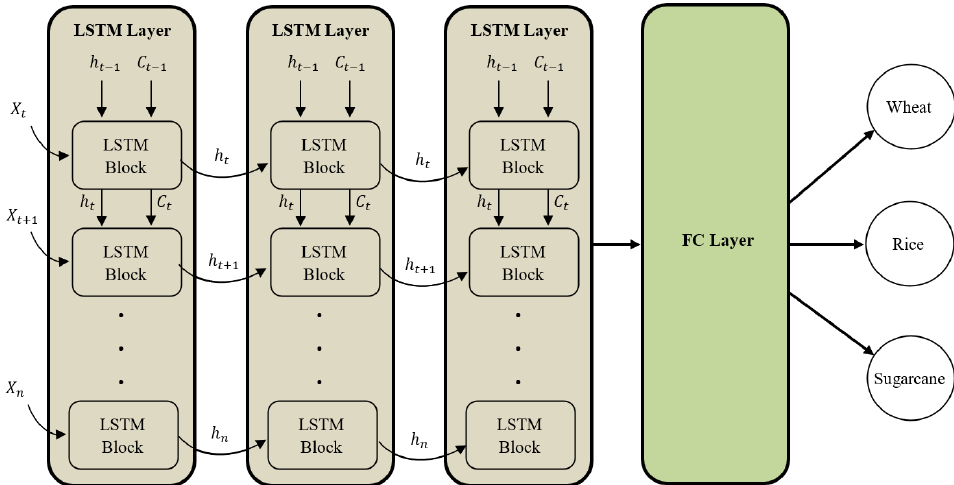
Figure 4. Architecture of the stacked LSTM